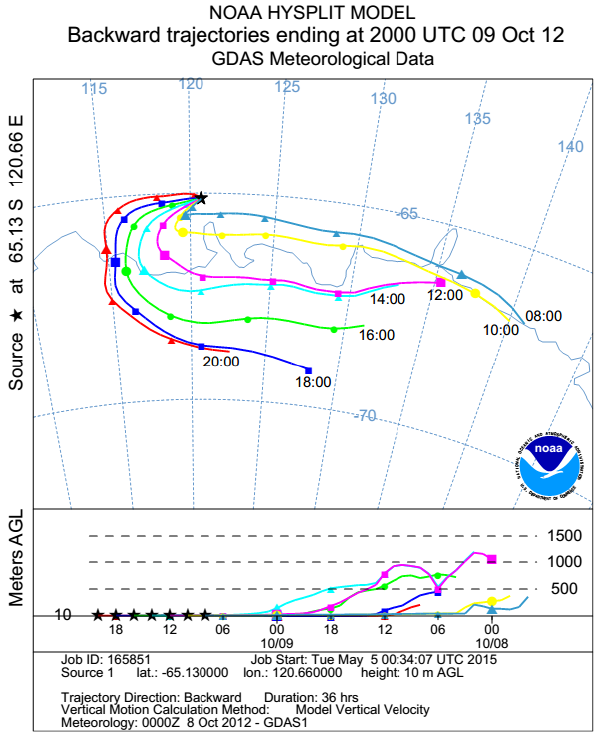
Figure A7. 36h backward trajectories released every 2h from the measurement location (10ma . s . l . ) and spanning the 9 October enhanced aerosol event.